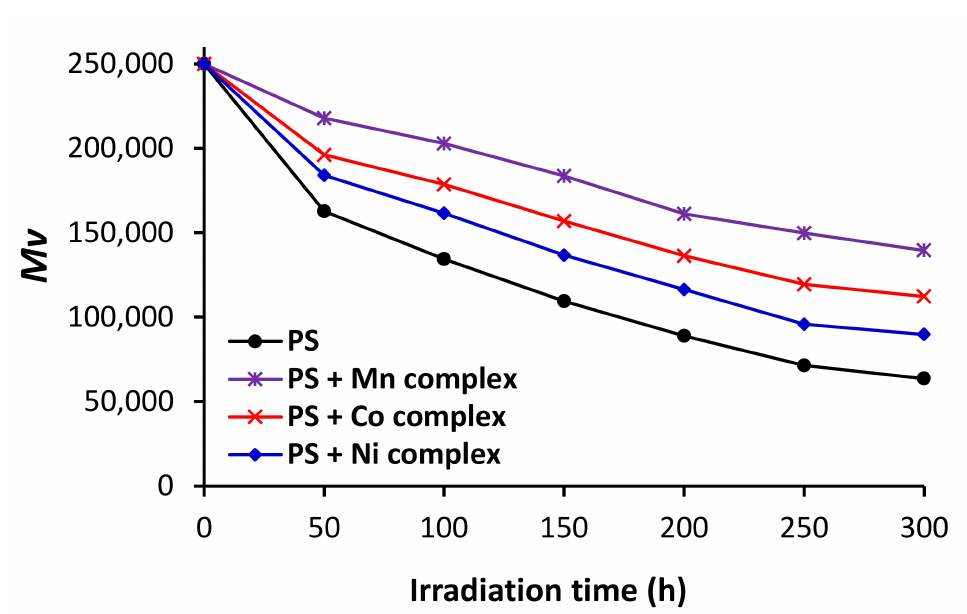
Figure 5. Changes in the M v of PS films as a function of UV